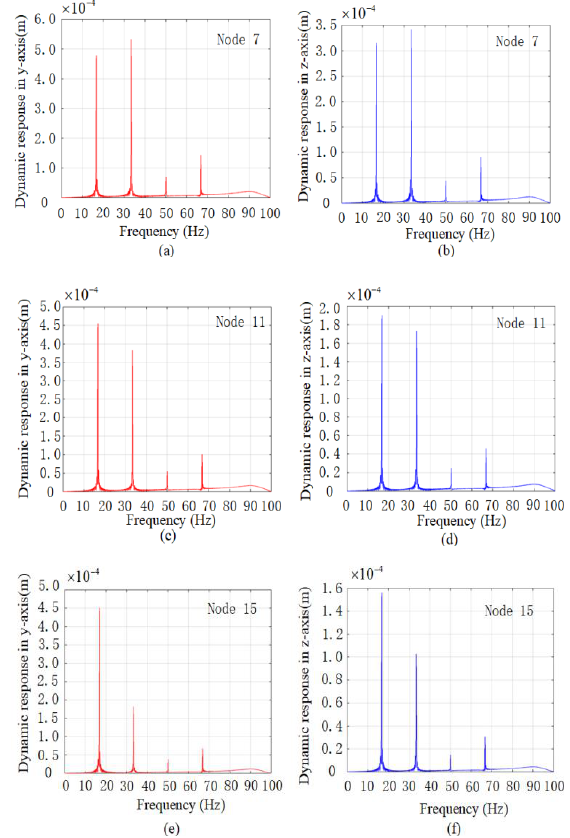
Figure 13. The mathematical simulated dynamic response with 0.4 mm parallel misalignment and 0.5 ◦ angular misalignment of nodes 7, 11, and 15 in the y -axis and z -axis. ( a ) Node 7 in the y -axis. ( b ) Node 7 in the z -axis. ( c ) Node 11 in the y -axis. ( d ) Node 11 in the y -axis. ( e ) Node 15 in the y -axis. ( f ) Node 15 in the z -axis.